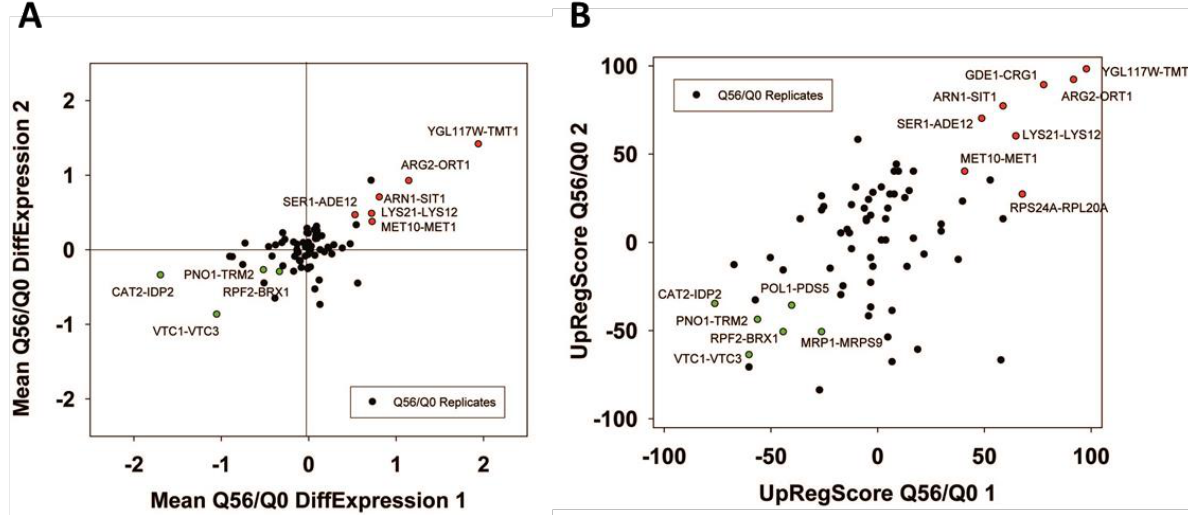
FIGURE 5: Analysis of the toxic effects of polyglutamine expression with pQ56. Correlation between two experiments of Q56-expression induced toxicity based on the average expression differences (A) or the UpRegScore (B) The clusters, which are significantly up- or downreg- ulated in both experiments, are highlighted in the respective